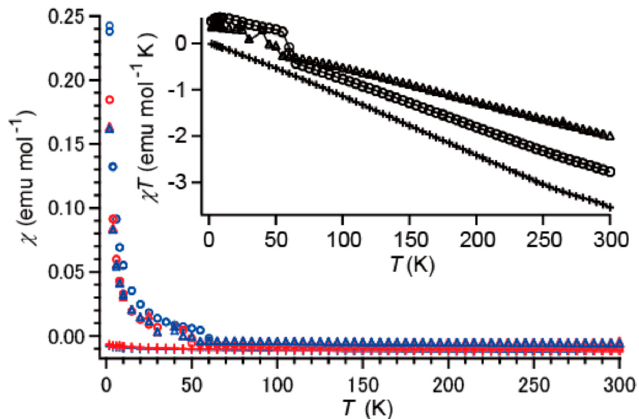
Figure 6. Temperature ( T ) dependence of the magnetic susceptibility ( χ ) of 1 (circles), 2 (crosses) and 3 (triangles). Both field-cooling (blue) and zero-field-cooling (red) processes are shown. (Inset) χ T vs. T of 1 – 3 for the same field-cooling data as those in the main panel; the small jumps around 50 K in 1 and 3 are extrinsic, possibly due to residual adsorbed oxygen.